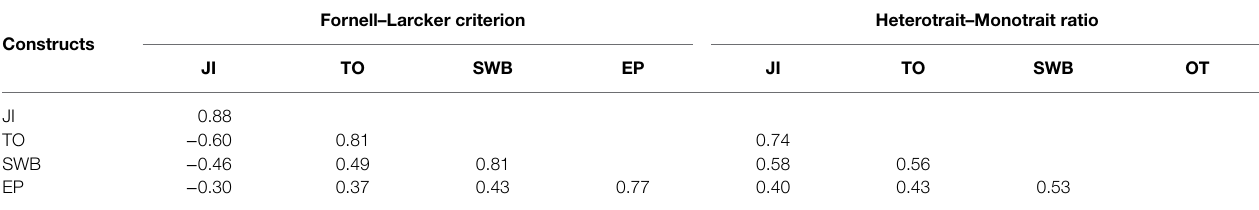
TABLE 3 | Discriminant validity.